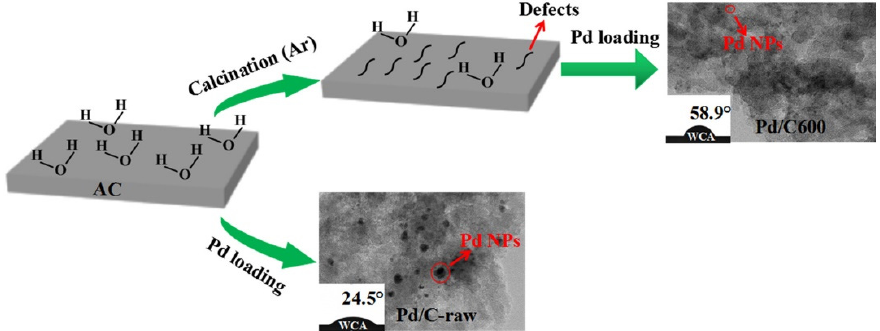
Figure 25. Temperature effect on the hydrophobicity of carbon and the dispersion of the Pd on carbon. Reprinted with permission from [63], © 2020 The Chemical Industry and Engineering Society of China, and Chemical Industry Press Co., Ltd.